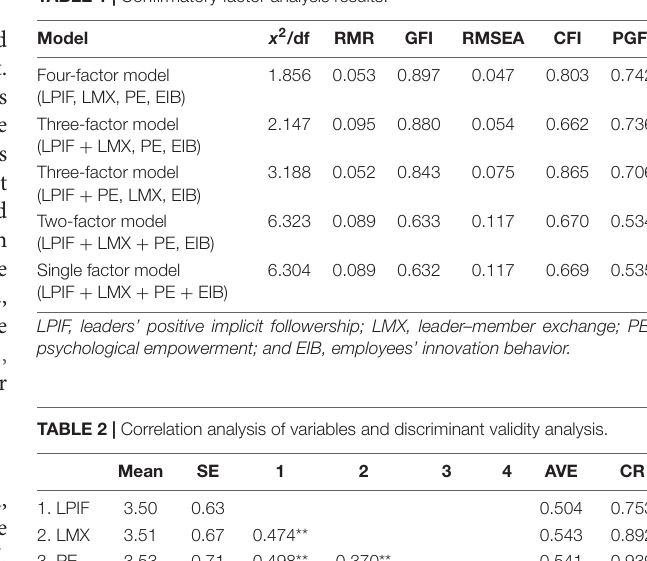
TABLE 1 | Confirmatory factor analysis results.